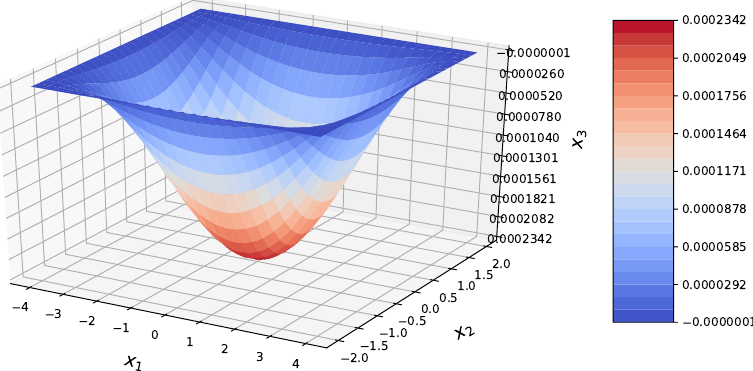
Figure 20. Three-dimensional plot of the deflection of a rectangular plate with clamped edges.